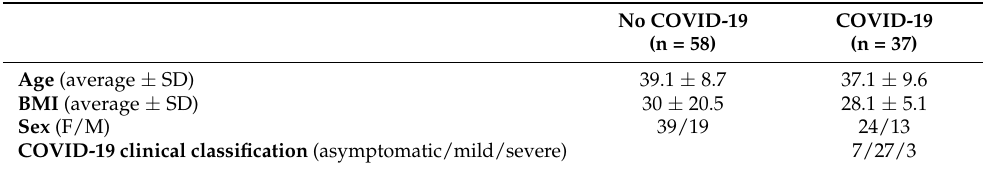
Table 1. Clinical and demographic features of enrolled participants.